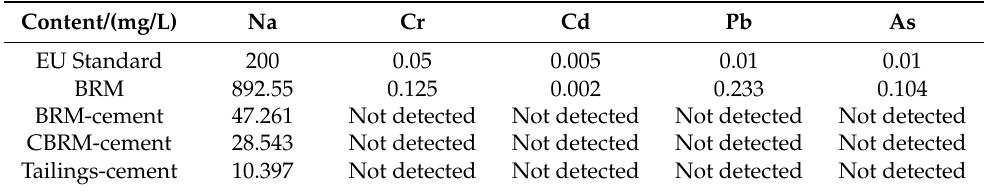
Table 10. The SiQ n and RBO of CBRM-cement and